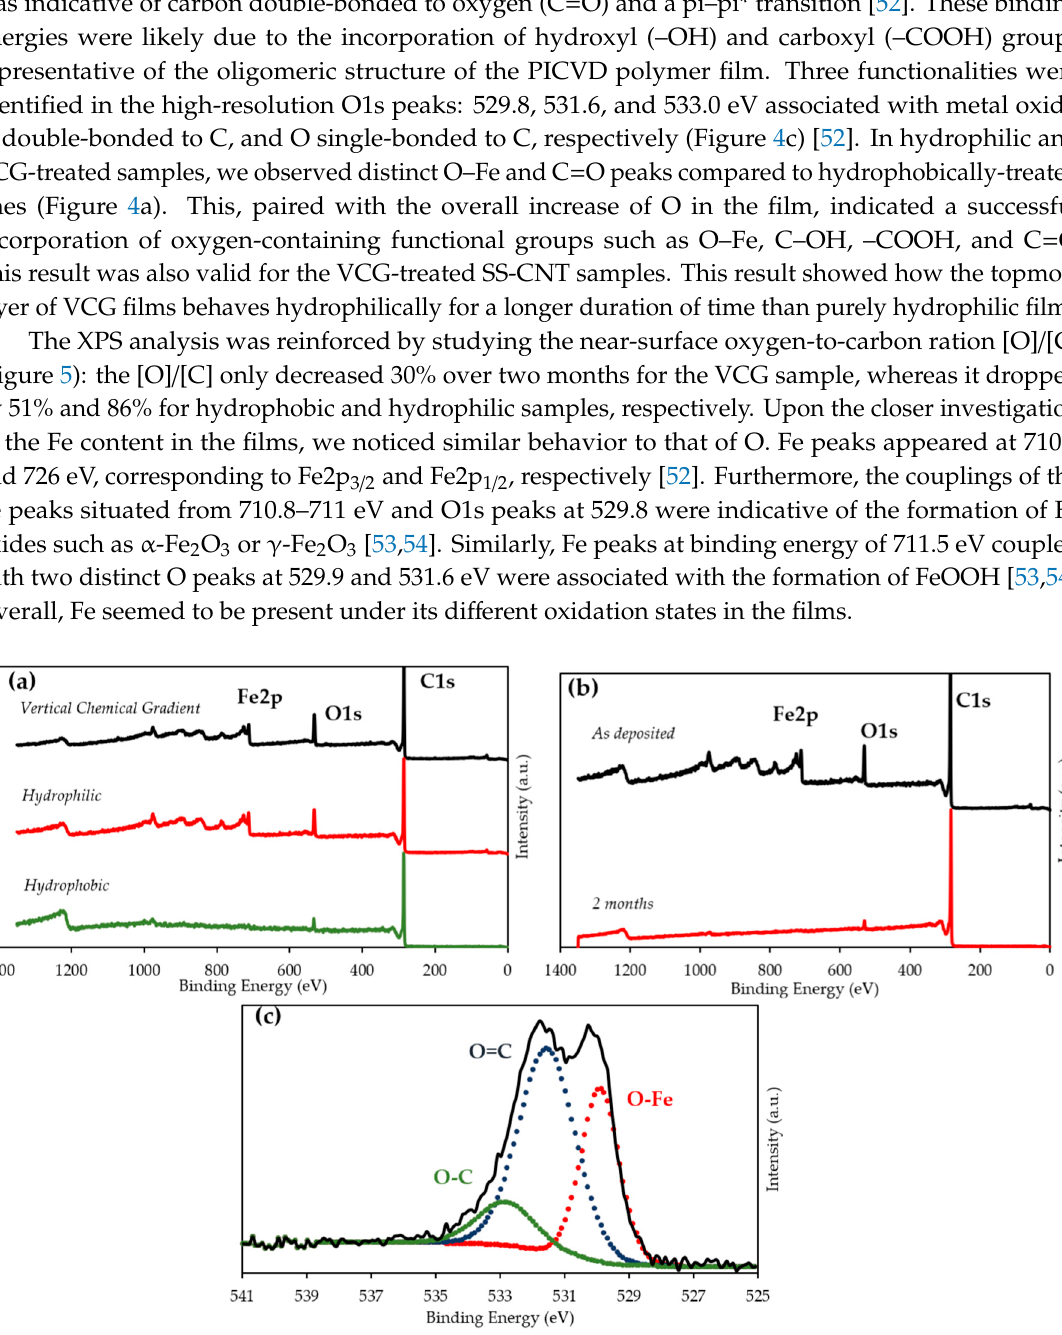
Figure 5. Aging of the coating observed thanks to the [O]/[C] ratio of PICVD-treated SS-CNTs as deposited and after 2 months. 3. Discussion.